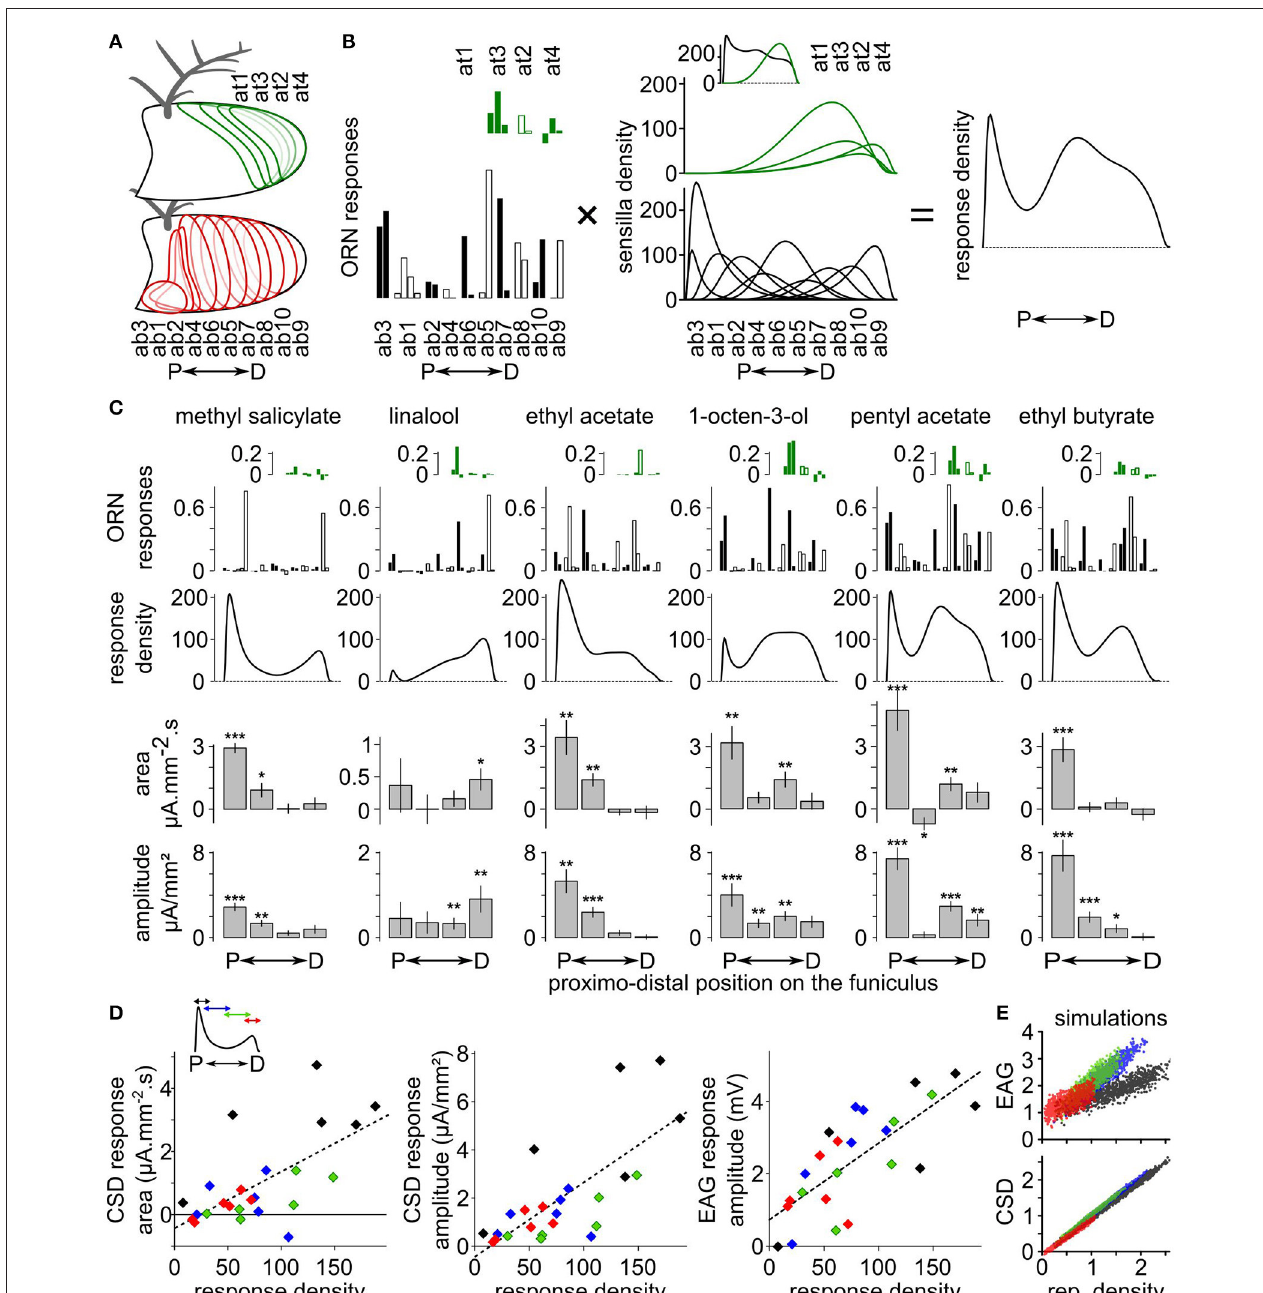
FIGURE 3 | Comparison between CSD maps and cellular maps in Drosophila melanogaster . (A) Drawings of a funiculus of D. melanogaster including the approximative distribution of each type of basiconic (red contours) and trichoid (green contour) sensilla. The name of the sensilla types are ordered from the most proximal to the most distal one (de Bruyne et al., 2001; Lin and Potter, 2015; Grabe et al., 2016). P, proximal; D, distal. (B) Method for estimating the response density across the antenna. The response density across the antenna (right) is defined as the sum of the response level of each ORN types (left) multiplied by the spatial density of the corresponding sensilla type (middle). Left, the response levels to a given stimulation are listed in a distal to proximal order. The response levels in consecutive sensilla types are alternatively indicated with filled and empty bars, and each sensilla type include two to four ORNs. Responses of trichoid sensilla (green) are indicated above responses to basiconic sensilla (black). Middle, the sensilla density for each sensilla type was approximated with a logit normal distribution weighted by the number of sensilla on the antenna (Grabe et al., 2016). The units are the number of sensilla per unit of antennal length. A uniform distribution with a value of 100 would mean that the antenna contains 100 sensilla. Inset: total density of basiconic and trichoid sensilla. (C) Functional maps in response to six chemicals. The ORN responses (up) were extracted from the database DoOR (Münch and Galizia, 2016) and are expressed in consensual scaled unit. The responses are shown in the same sensilla order as in panel (B) . The resulting response densities along the proximo-distal axis are shown below. Down: the bar